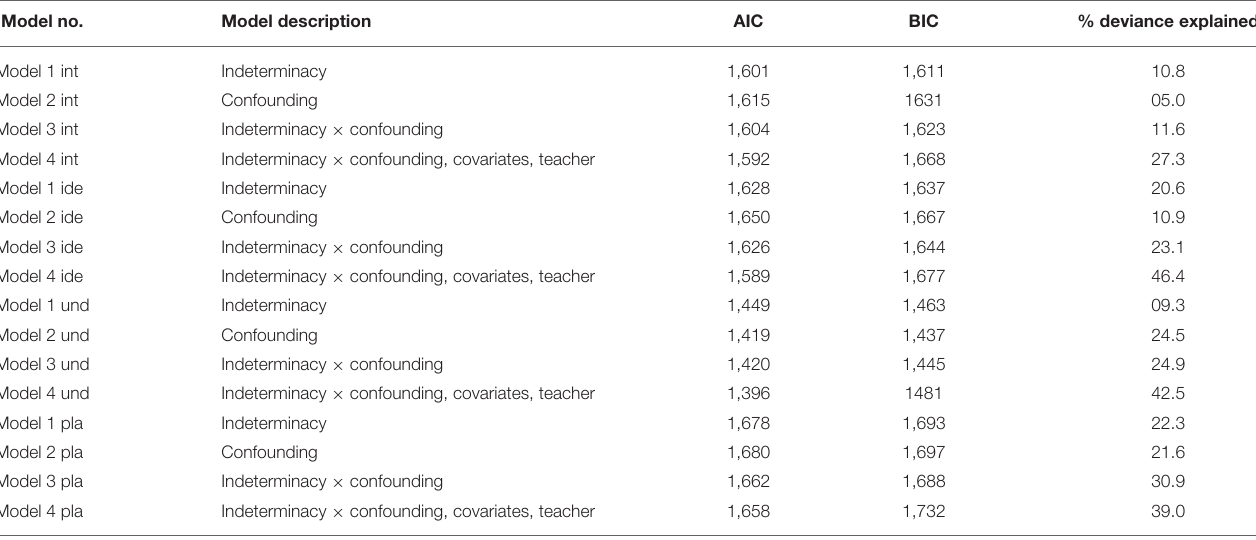
TABLE 4 | Relative model fit and explained deviance for the 16 fitted general additive mixed models. Model